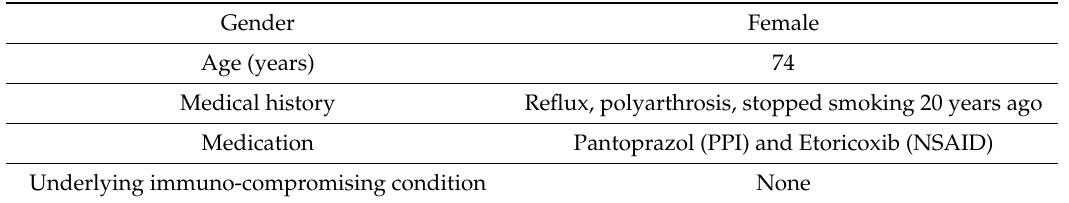
Table 1. Patient